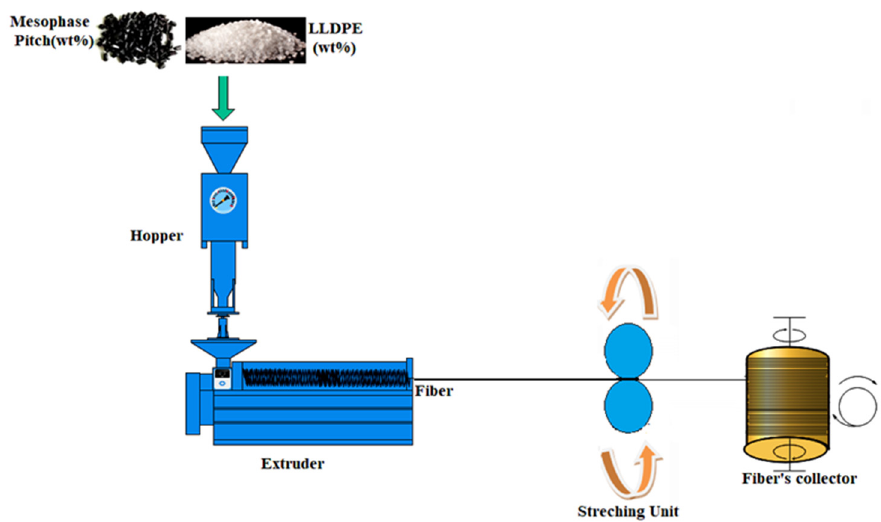
Figure 1. Production of fibres from melt blends . Table 1. Blends in terms of wt% mesophase pitch and LLDPE .